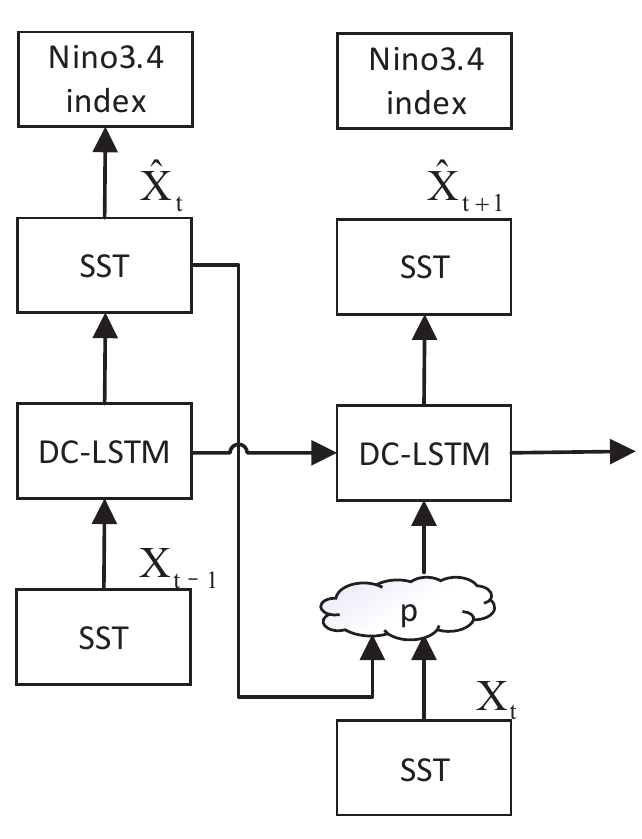
Figure 2. The diagram of the overall